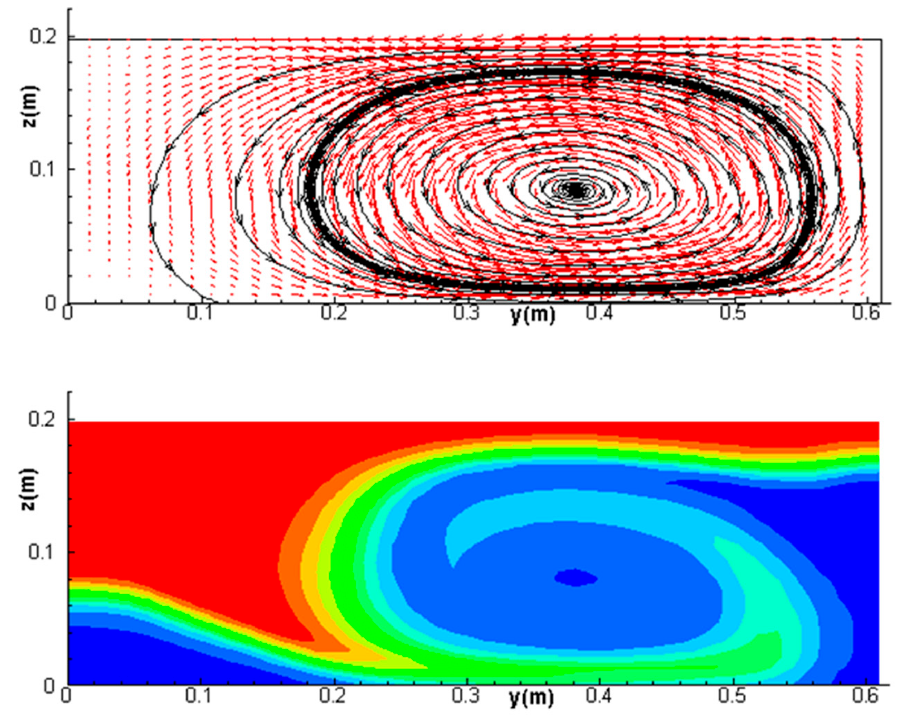
Figure 12. Predicted secondary flow (top) and Fish Distribution Function field (bottom) at the main channel cross-section 0.5 W upstream of the juncture for the vane case.